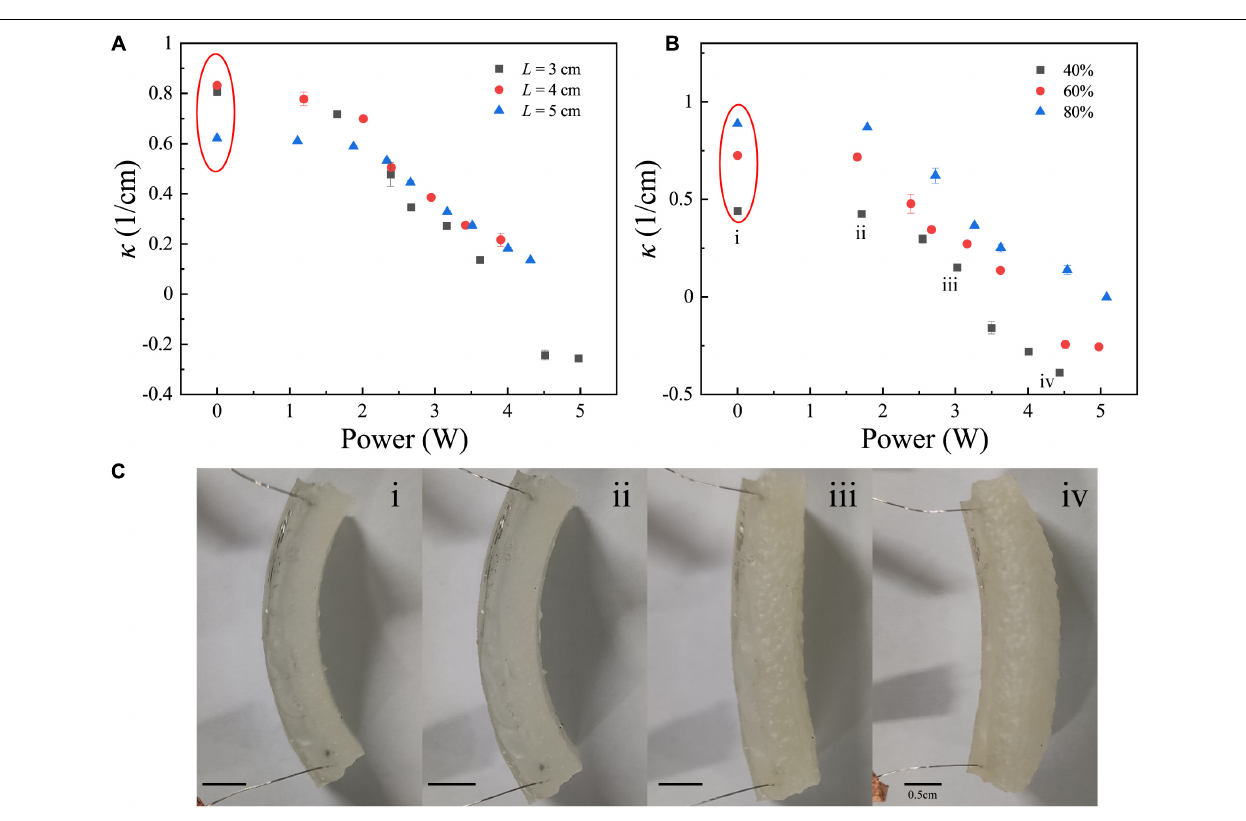
FIGURE 3 | Variation in the average curvature of the slender pre-strained bilayer structure. (A) Effect of the aspect ratio on the deformation under a constant pre-strain of 60%. (B) Effect of the pre-strain on the deformation under a constant structure length of 3 cm. (C) Deformation sequence as the thermal stimulus is applied to the bilayer structure with 40% pre-strain and 3-cm